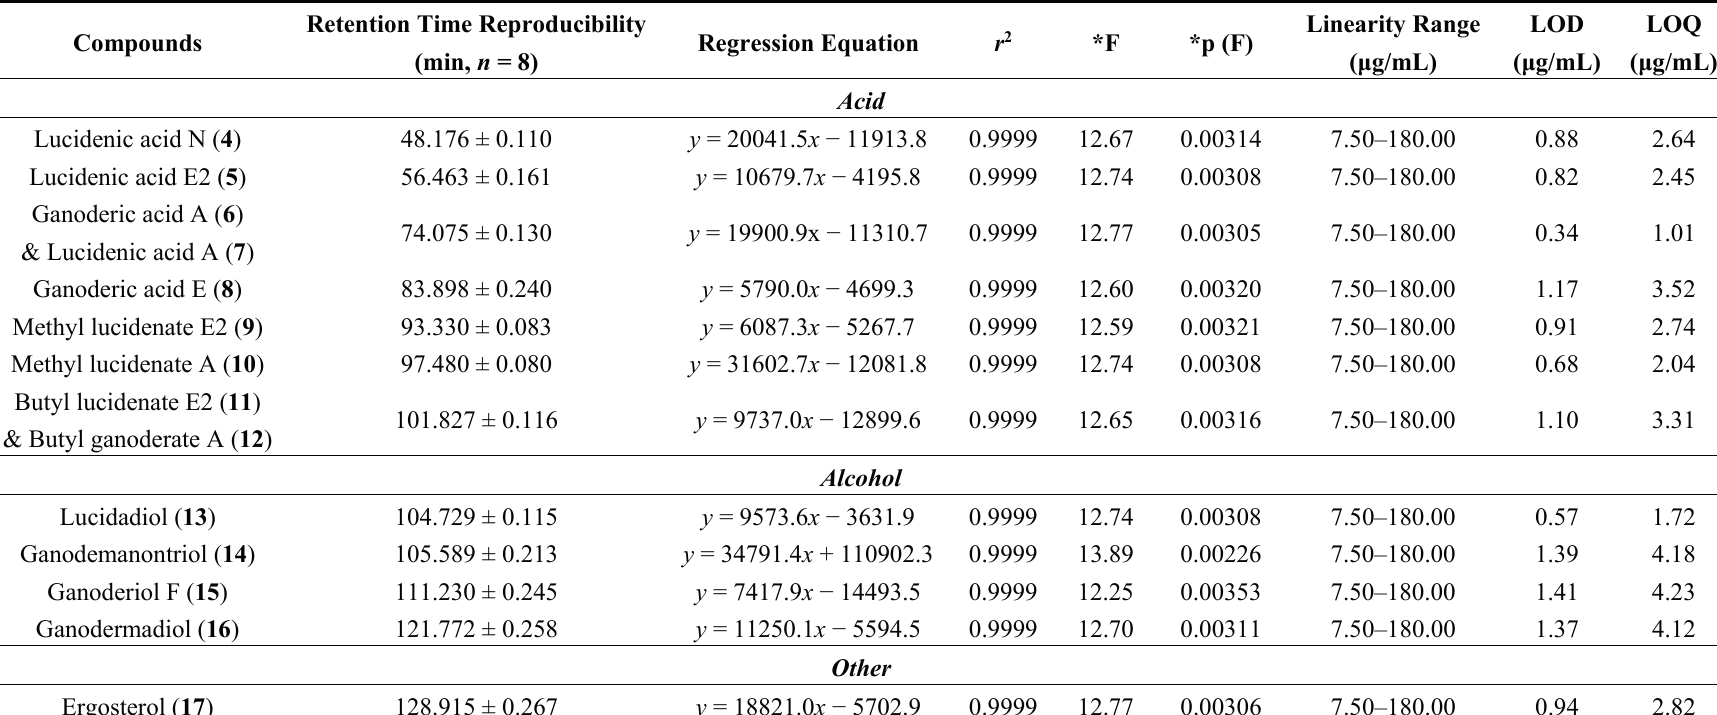
Table 1. Retention time reproducibilities, regression equations, correlation coefficients ( r 2 ), F-test, p (F), linearity ranges, LOD, and LOQ of the compounds 4 – 17 ( n =